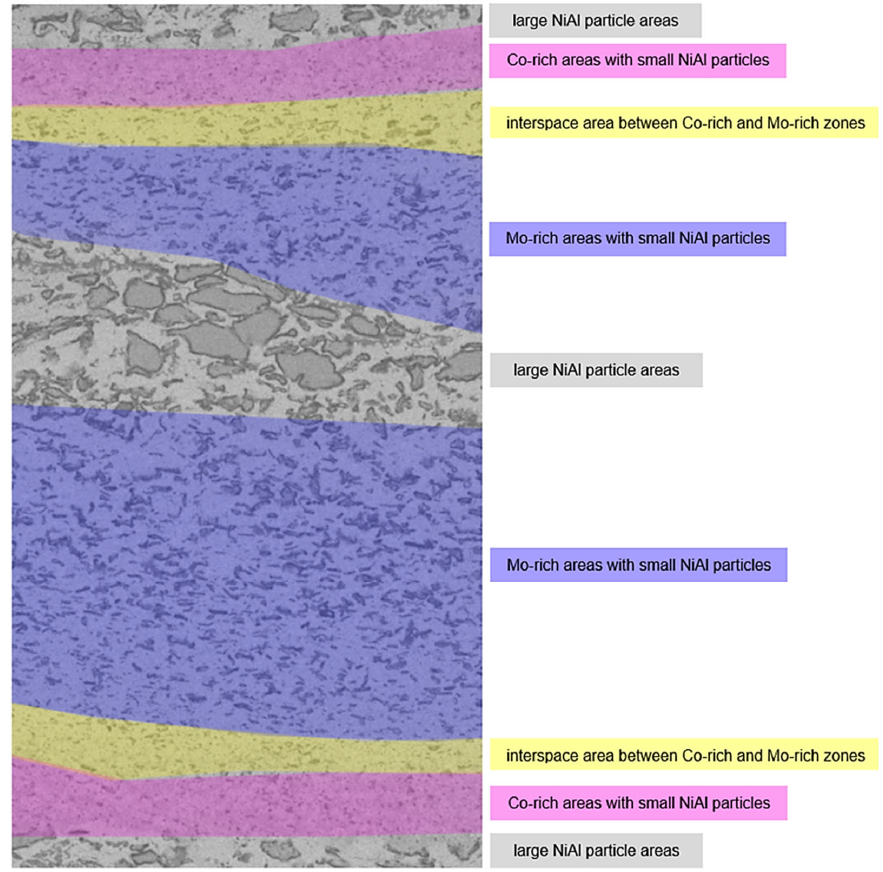
Figure 10. Wedge ‐ shaped regions enriched with various alloy components scheme. Figure 10. Wedge-shaped regions enriched with various alloy components